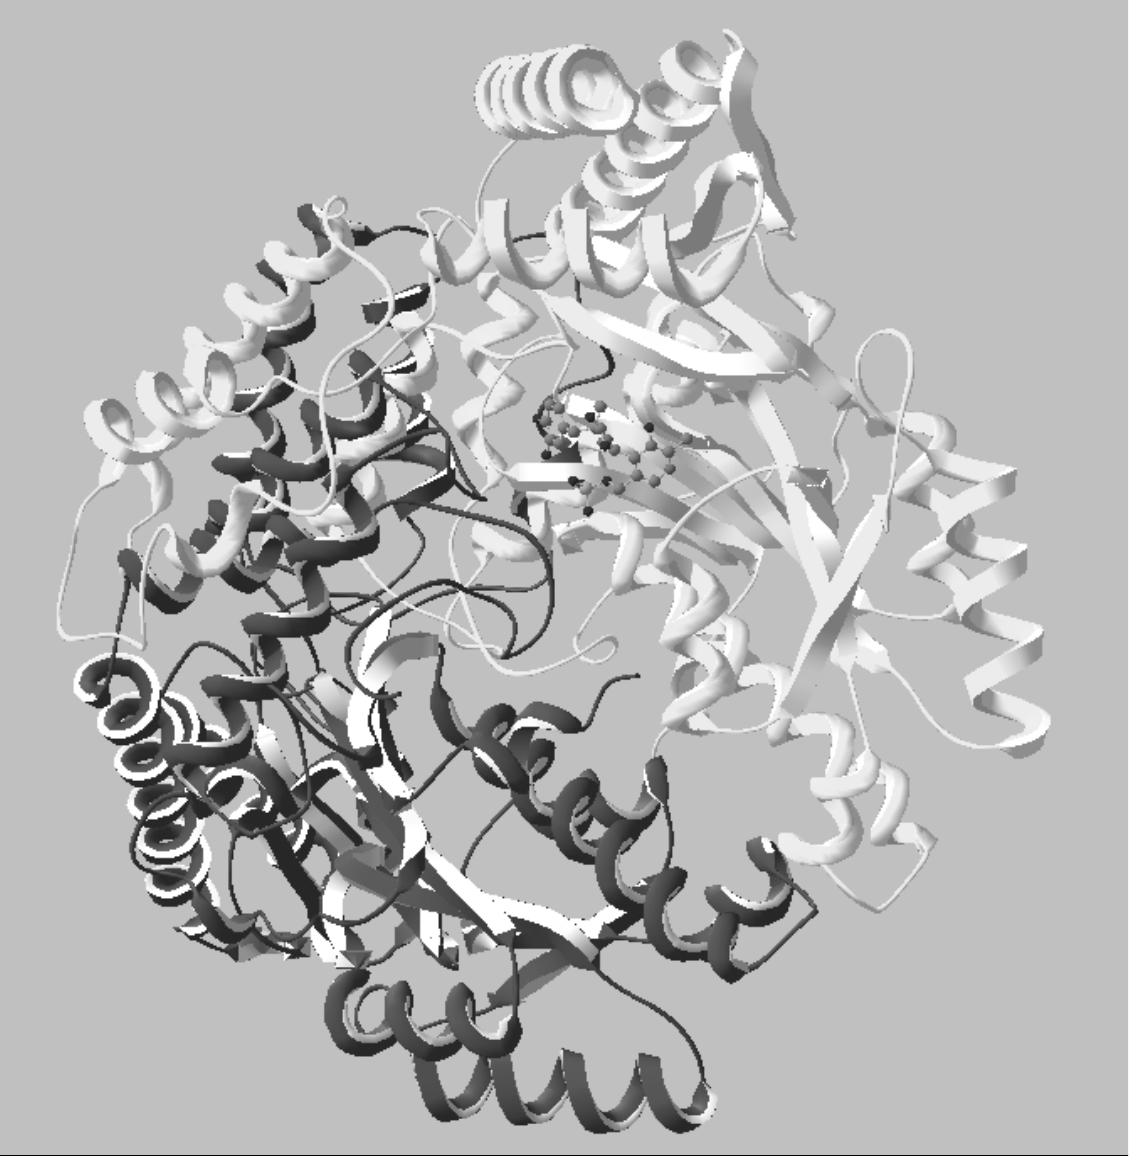
Figure 3: The crystal structure of pig kidney DOPA decarboxylase (DDC) is used as a template. The structure consists of two identical amino acid chains (Homo Dimer). In the figure the protein is shown in complex with the inhibitor Carbidopa. The chains (dark and bright) are represented as ribbons, whereas the inhibitors are repre- sented as "ball and